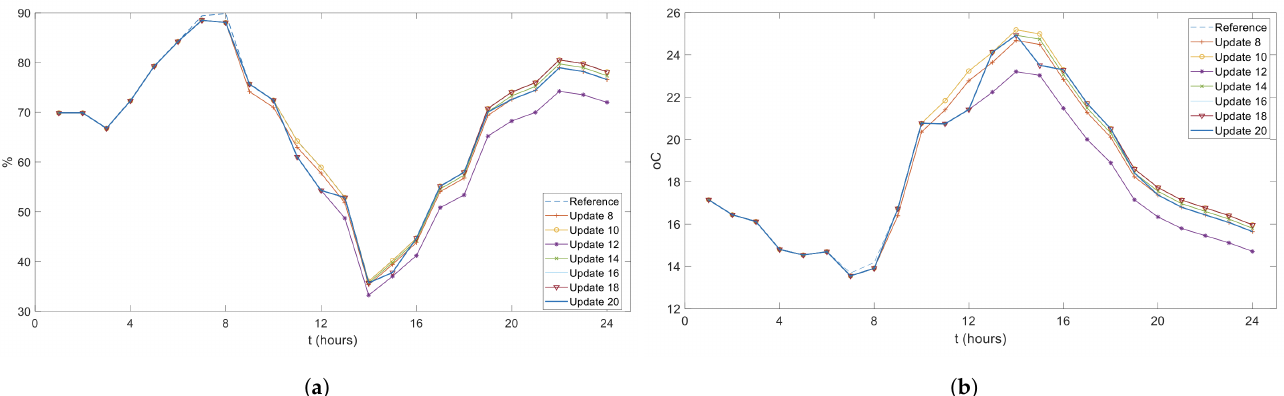
Figure 12. Performance of neural network against regression tree with best-fit optimizer.